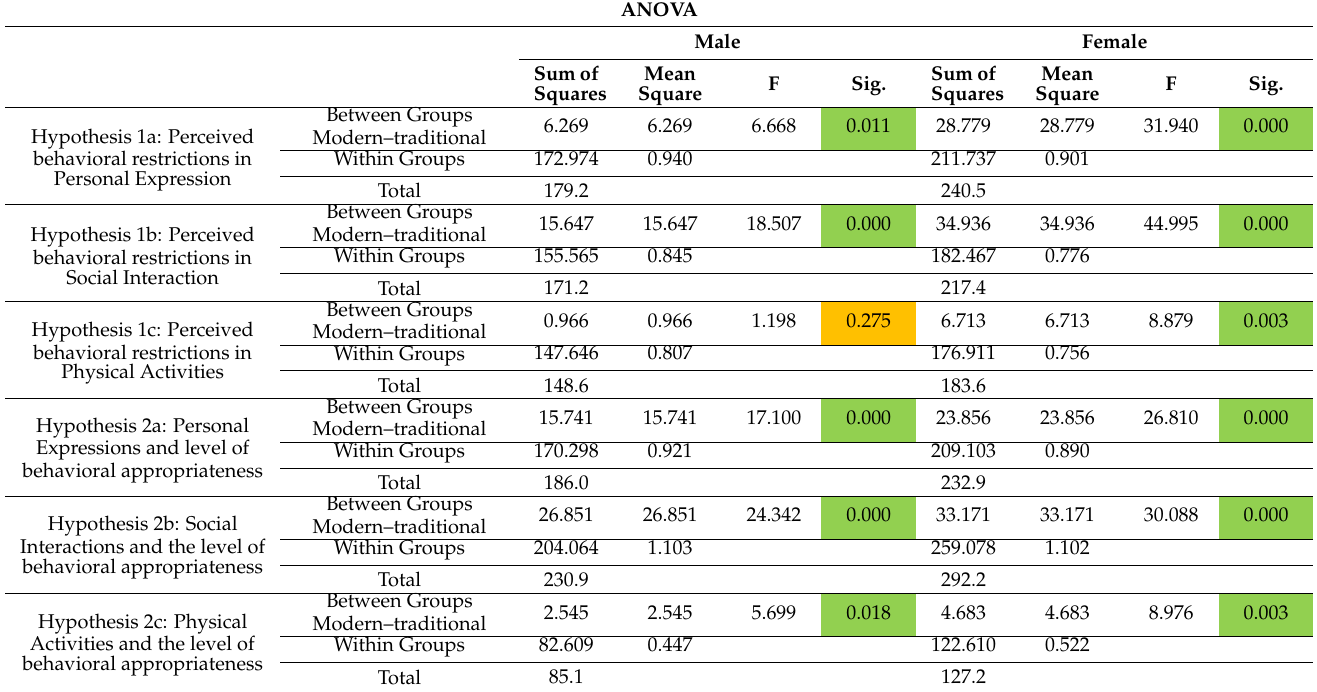
Table 1. Analysis of variance between two districts for both genders. ANOVA Male Female Sum of Sig. Squares